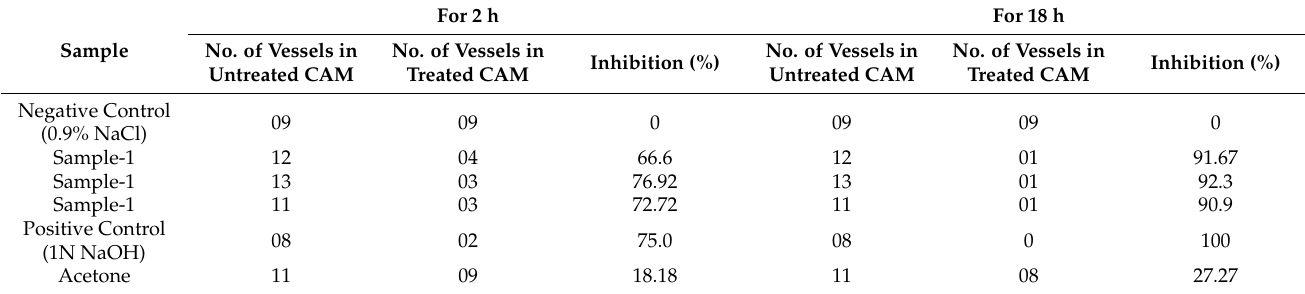
Table 1. Anti-angiogenesis effect of dimer of epicatechin in Hen’s Egg Test on Chorio Allantoic Membrane (HET-CAM) test.